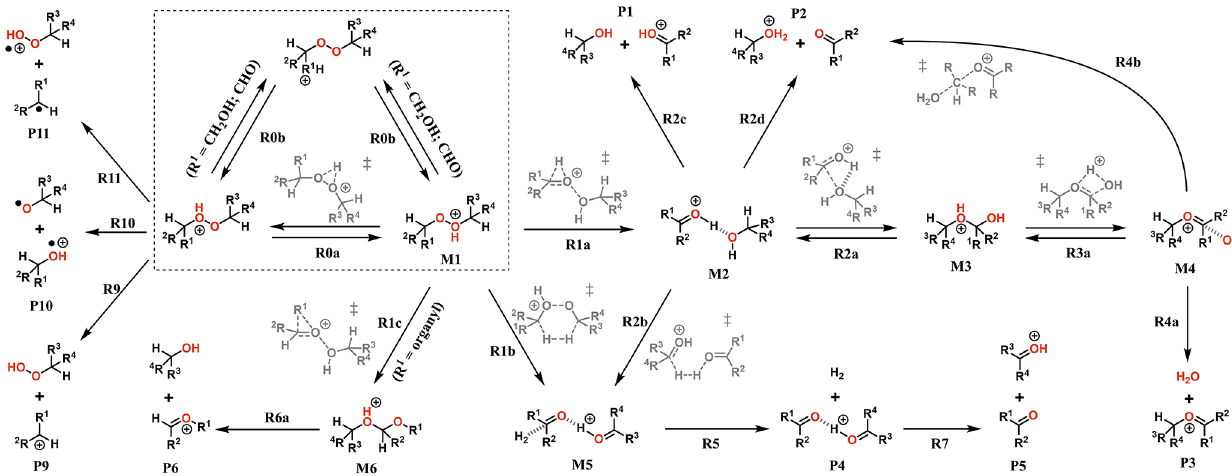
Figure 5. General mechanism for the decomposition of ROOR following protonation. Species within the dashed box are the initial pro- tonation isomers. Transition states are shown in gray. Some pathways are not available for every ROOR investigated. Compound-specific pathways with yields less than 0.1% for any conditions are omitted for clarity.